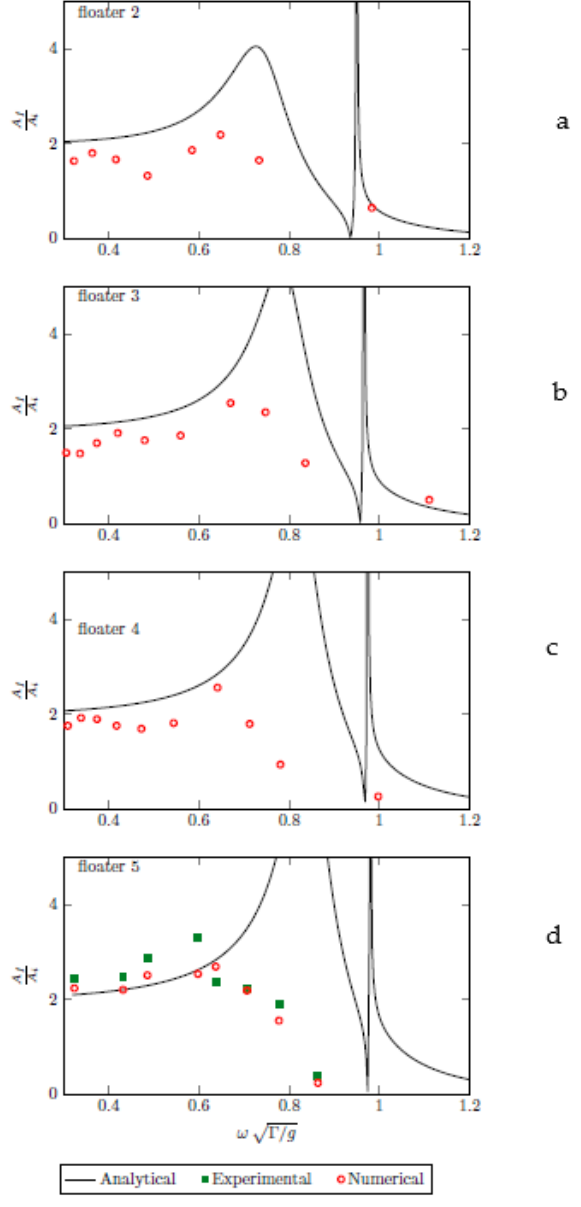
Figure 9. Floater response with different drafts at h = 0.6 m and D = 0.01 m. ( a ) Γ = 0.10 m; ( b ) Γ = 0.15 m; ( c ) Γ = 0.20 m; ( d ) Γ = 0.25